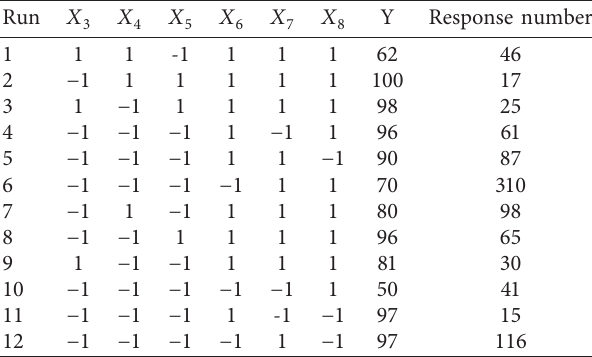
Table 3: One replicate for Example 1.